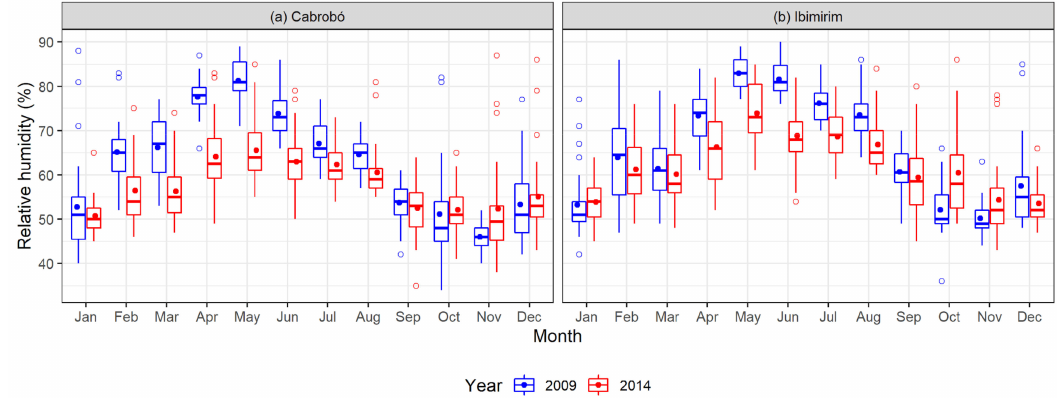
Figure 4. Monthly boxplots of hourly relative humidity data in the Cabrob ó and Ibimirim sites in 2009 (wet year) and 2014 (dry